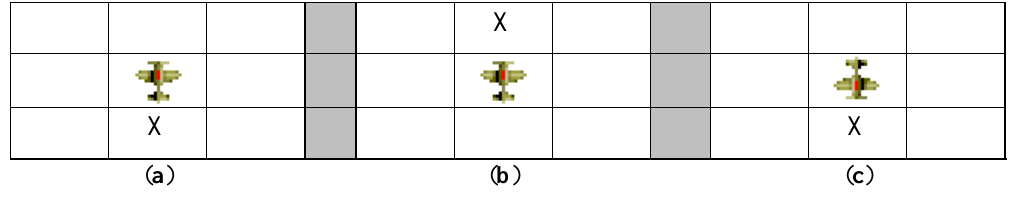
Figure 7. Example of three scenarios with obstacles.